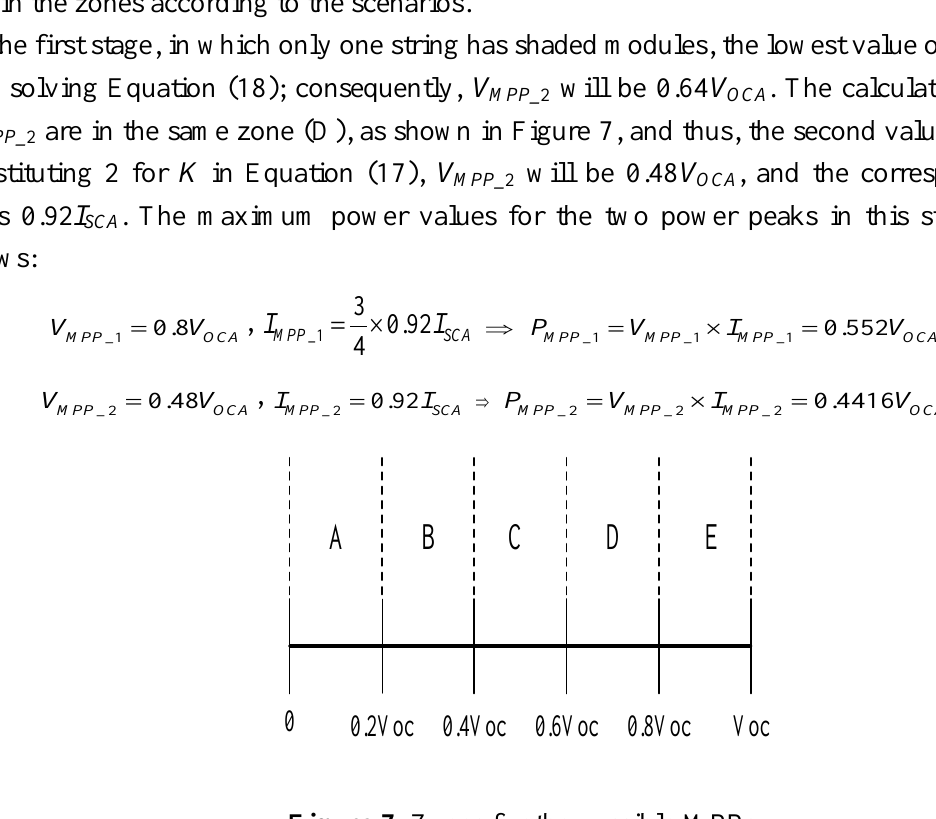
Figure 7. Zones for the possible